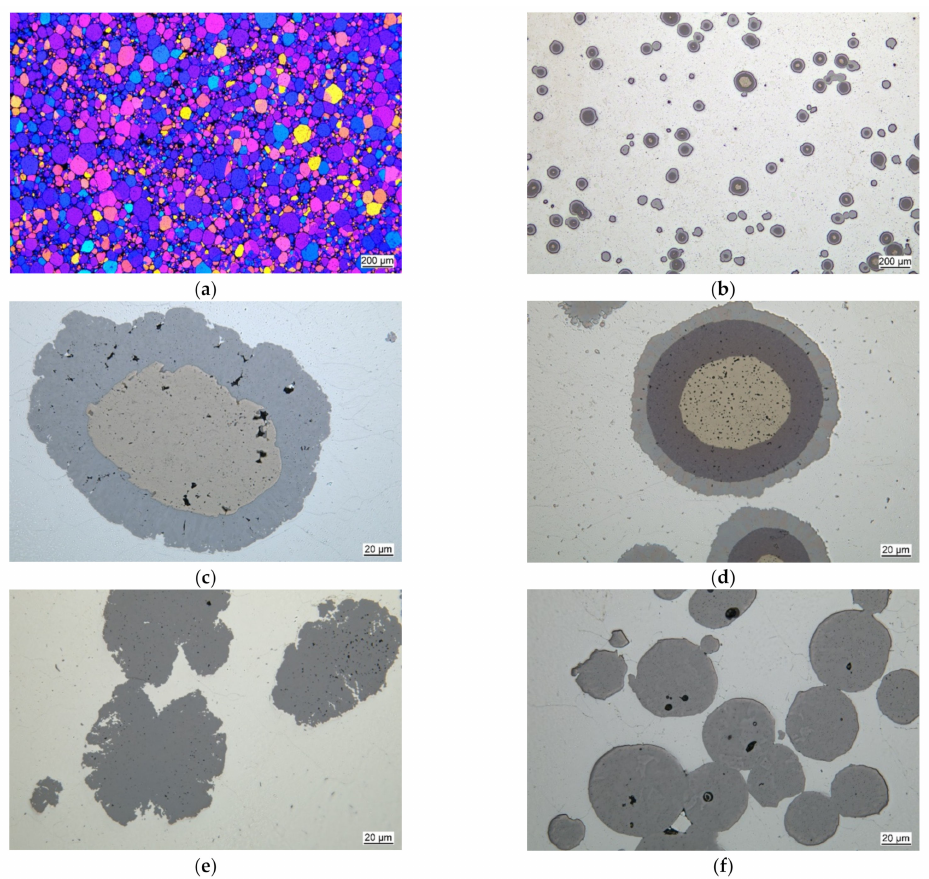
Figure 6. Images of the different microstructures through a reflected light microscope of ( a ) Al and Al-matrix with 10 mass-% for ( b ) Ni-, ( c ) Co-, ( d ) Ni-, and ( e ) Fe-particles, and ( f ) Al-matrix with 30 mass-% Fe.